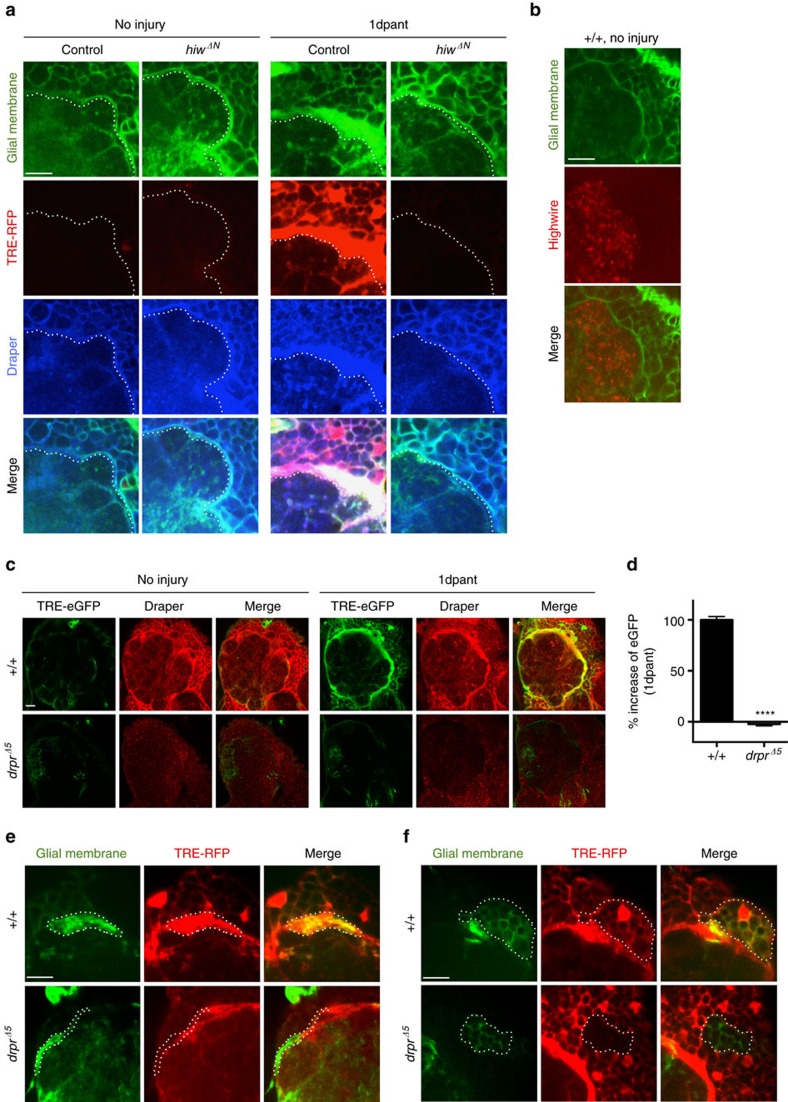
Glial transcriptional activation is downstream of axon degeneration and Draper signalling.(a) Glial responses to axon injury in controls and highwire null (hiwΔN) animals after axotomy (1 day after bilateral antennal ablation, 1 dpant). Note glial membrane hypertrophy, activation of the of TRE reporter and upregulation of Draper (anti-Draper) in cohort controls (hiwΔN/+; TRE-RFP-16/+; repo-Gal4, UAS-mCD8::GFP/+). highwire null animals (hiwΔN/Y; TRE-RFP-16/+; repo-Gal4, UAS-mCD8::GFP/+), where axon degeneration is blocked, showed no detectable activation of glia. Dotted line delineates edge of the antennal lobe. Representative images were shown from five animals. Scale bar=10 μm. (b) Highwire was highly enriched in the synaptic region in the antennal lobe, but not in the surrounding glial cells (labelled with repo-Gal4, UAS-mCD8::GFP/+). Representative images were shown from three animals. (c) Glia require Draper to activate TRE reporter 1day after antennal ablation. +/+: TRE-eGFP-16; +/+. drprΔ5: TRE-eGFP-16; drprΔ5. Representative images were shown from three animals. Scale bar=10 μm. (d) Quantification of the increase of eGFP immunoreactivity in (c). n=15 each. Unpaired t-test, 2-tailed. ****: P<0.0001. (e) Ensheathing glial MARCM clones (green, outlined) responding to axotomy at day 1 post antennal ablation. Control ensheathing glial clones (+/+) became hypertrophic and exhibited strong TRE reporter activation (red) 1 day after antennal ablation, while draper null (drprΔ5) clones did not respond to axotomy (that is lack of membrane hypertrophy, and activation of TRE reporter) while neighbouring control cells were activated. +/+: TRE-RFP-16, UAS-mCD8::GFP/repo-FLP6–2; FRT2A, FRT82B/tub-Gal80, FRT2A, repo-Gal4. drprΔ5: TRE-RFP-16, UAS-mCD8::GFP/repo-FLP6–2; drprΔ5, FRT2A/tub-Gal80, FRT2A, repo-Gal4. Representative images were shown from four animals. Scale bar=10 μm. (f) TRE-RFP reporter activity in cortex glial MARCM clones (dotted line, green) 1 day after antennal ablation. Similar to ensheathing glia, cortex glial clones that lacked Draper (drprΔ5) failed to activate TRE reporter. Genotypes as in (e). Representative images were shown from four animals. Scale bar=10 μm.